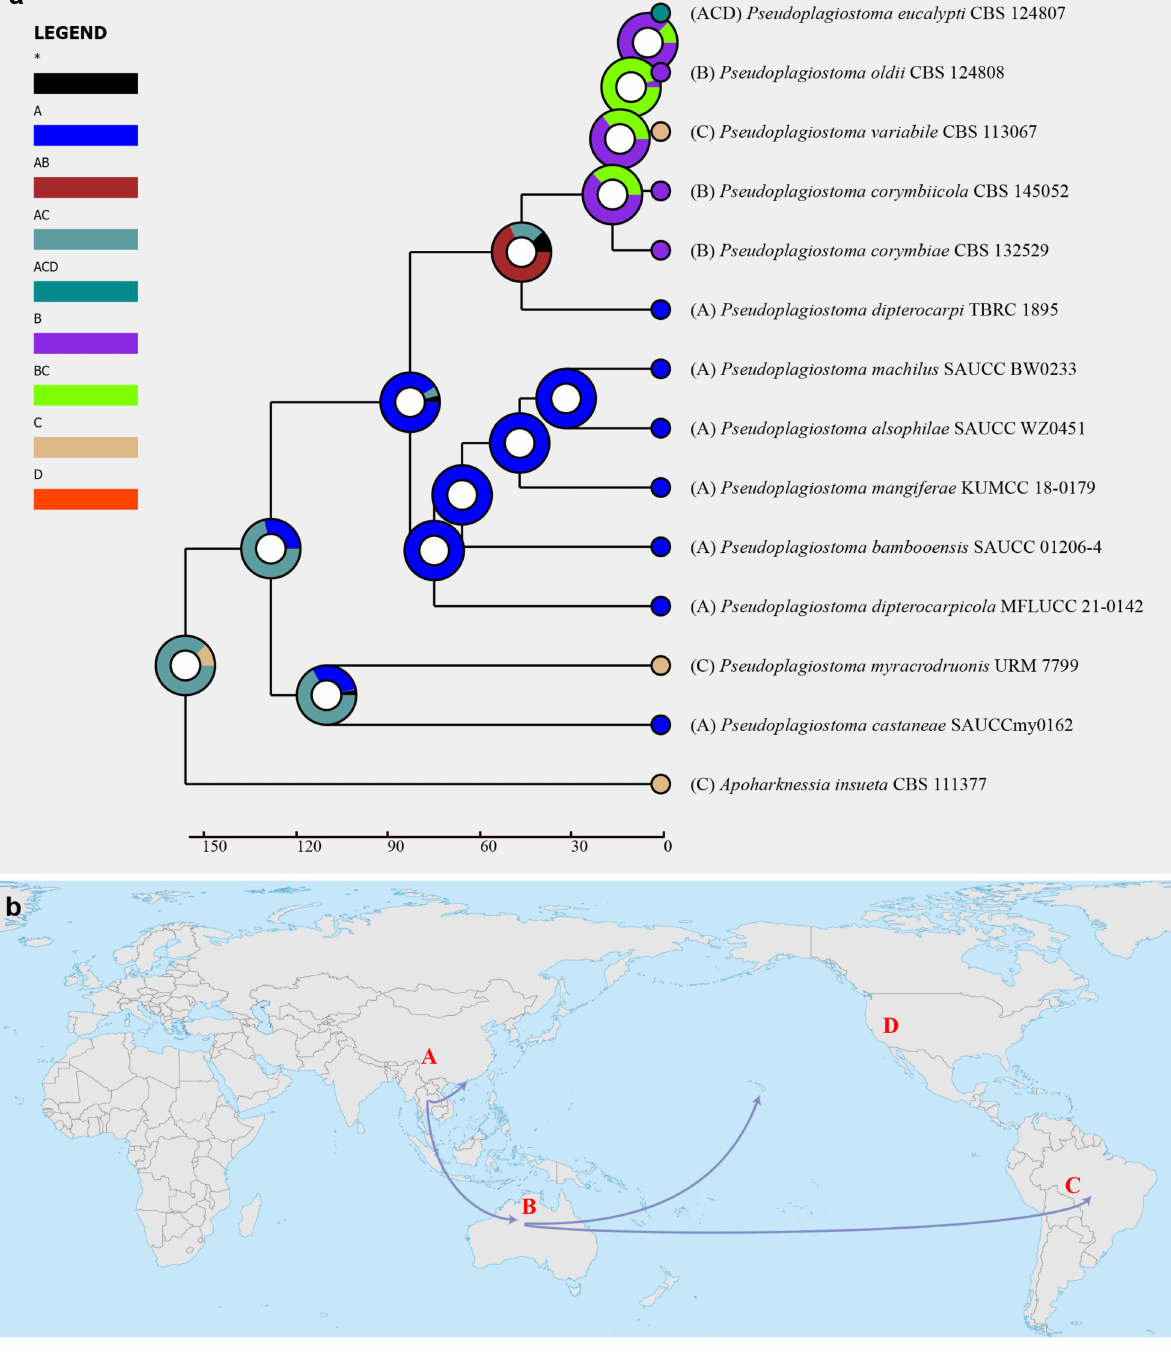
Figure 3. ( a ) Ancestral state reconstruction and divergence time estimation of Pseudoplagiostomataceae using a dataset containing ITS, LSU, rpb2 , tef1 α , and tub2 sequences. A pie chart at each node suggested the possible ancestral distributions deduced from Statistical Dispersal–Extinction–Cladogenesis (S–DEC) analysis completed in RASP. A black asterisk stands for other ancestral ranges. ( b ) Possible dispersal routes of Pseudoplagiostomataceae . Areas were marked as follows: (A) Asia, (B) Oceania, (C) South America, (D) North America, (A,B) Asia and Europe, (A,C) Asia and South America, (B,C) Oceania and South America, and (A,C,D) Asia, South America, and North